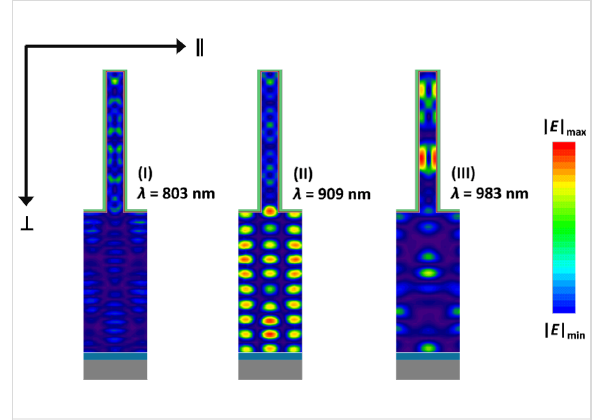
Figure 5: Distribution of the electric field inside the absorber layer of the NW device for three different wavelengths: (I) 803 nm, (II) 909 nm and (III) 983